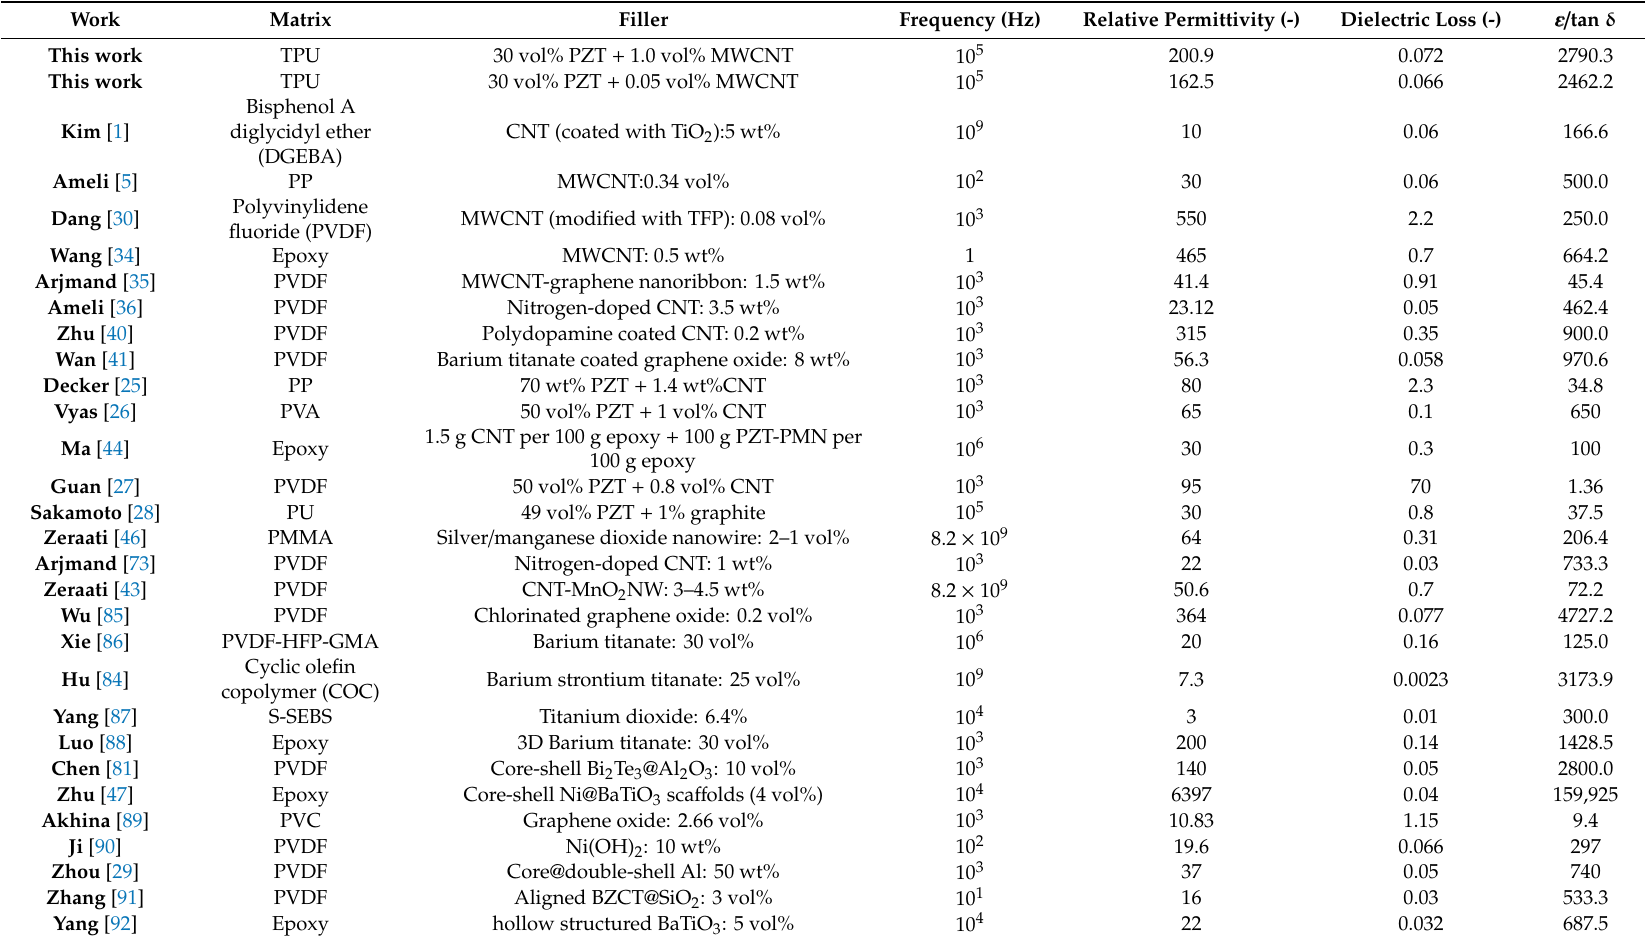
Table 1. A summary of dielectric parameters in recent